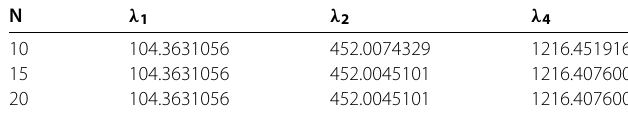
Table 1 The approximate eigenvalues on the unit disk B 2 in R 2 N λ 1 λ 2